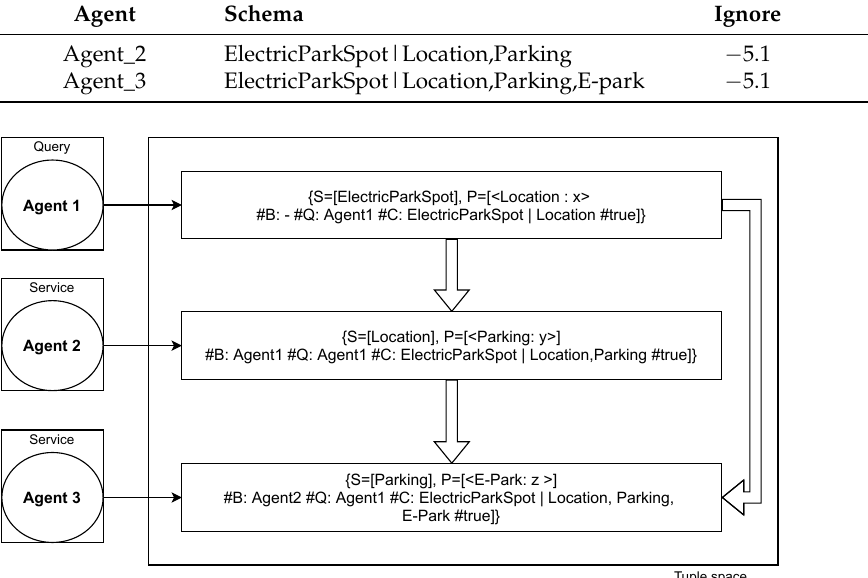
Table 3. Qmatrix of the agents after the second query (semantic version).